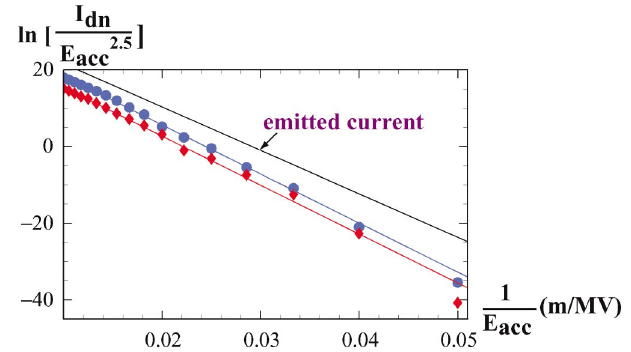
downstream detector, assuming uniform (circles) or nonuniform current.